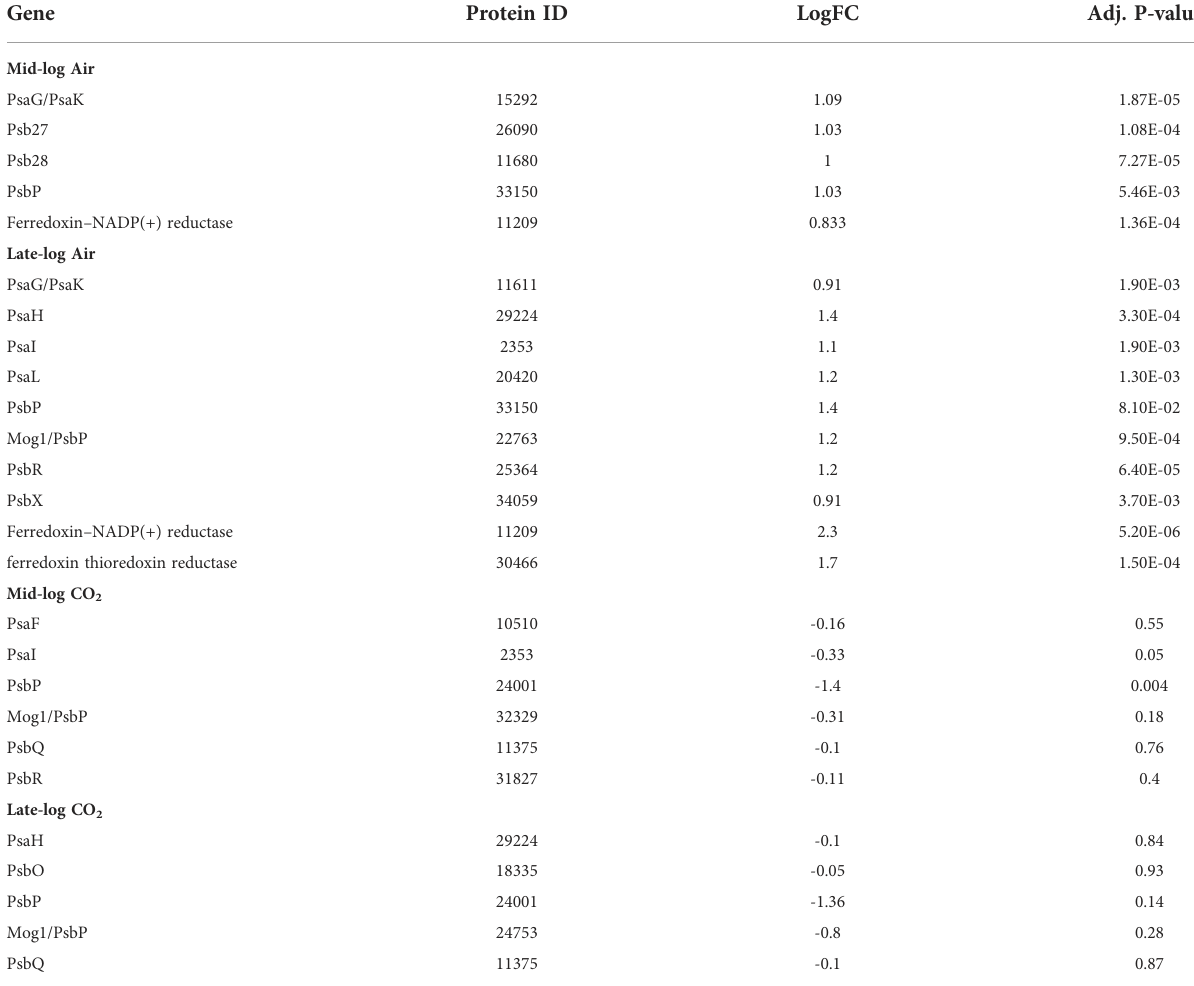
TABLE 1 Log fold changes, adjusted p-values, and protein ID of transcripts encoding photosystem I and II subunits of S. obliquus grown in the presence of switchgrass in ambient and 1% CO 2 during mid- and late-log phase growth. Gene Protein ID LogFC Adj. P-values